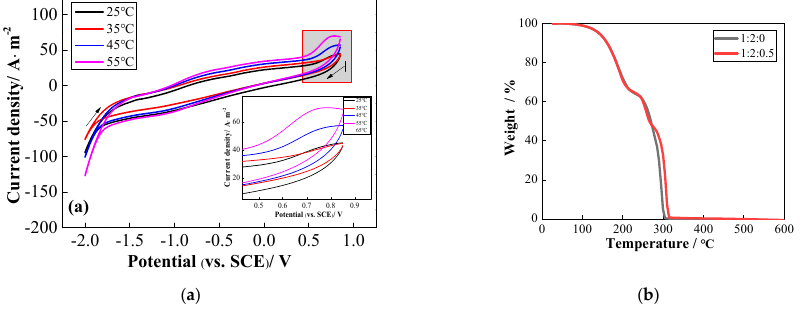
Figure 1. ( a ) Cyclic voltammograms of 1:2:0.5 TDES at different temperatures with a scan rate of 100 mV·s − 1 at room temperature (25 °C); ( b ) TG curves of BDES and 1:2:0.5 TDES. of BDES(TDES) show two mass drops, which means the decomposition of 2 organic com- ponents. The thermogravimetric curves of TDES show three mass drops, which means the decomposition of 3 organic components. The hydrogen bond network of the two solvents begins to break slightly at 4 °C and appears to obviously fracture above 10 °C. The decom- position rate of the hydrogen bond is accelerated above 150 °C. The components of the solvents began to decompose as the temperature continued to rise. Both solvents have better thermal stability. Viscosity has a great influence on the mass transfer in DESs, which is an important parameter that determines the efficiency of flow batteries. Viscosity is closely related to the intermolecular interaction of DES components. The stronger the hydrogen bonds be- tween molecules are, the bigger the viscosity of the prepared DES is [38]. The viscosity of DES is easily affected by the size of the cationic, anionic components, and the voids in the liquid [39]. Through the design of controlling the molar ratio of glycerin, the results sug- gest that the viscosity of the solvent in which the ratio of choline chloride to ethylene gly- col to glycerol of 1:2:0.5 decreases from 51.2 mPa·s for the binary eutectic solvent to 40.3 mPa·s after adding the redox pair (FeCl 3 ·6H 2 O) in Figure 2. The viscosity did not change much without the addition of the redox pair. The original hydrogen bond network struc- ture was appropriately destroyed by the introduction of glycerin and the low viscosity is obtained, which means that this design establishes a good balance and is beneficial to the flow battery. On the basis of controlling the viscosity of DES, the dynamics and efficiency are simultaneously improved. In the binary system, when the FeCl 3 ·6H 2 O redox pair is added, the hydrogen bonds of anions and cations in FeCl 3 ·6H 2 O can attract the -OH on the ethylene glycol to compete with choline chloride, forming a large number of relatively strong anion or neutral hydrogen bond, simultaneously supplying multiple sites of Cl. The coordination between CI and ethylene glycol occupies free sites, forming hydrogen bonds and van der Waals bonds of different strengths. The hexacoordinate FeCl 3 ·6H 2 O has an electron-withdrawing group, which can interact with ethylene glycol to form a single iron ligand. The ethylene glycol acts as a “bridge” to connect -OH, choline chloride with FeCl 3 ·6H 2 O to form a chloride ion–iron metal ion–ethylene glycol supramolecular complex [31]. When the battery is running, the large and complex molecular structure plays a great role in mass transfer resistance, and its viscosity is relatively large in Figure 2. After introducing the glycerol with different structures, the original hydrogen bond network structure is destroyed by microscopically adjusting the electronegativity differ- ence between the hydrogen bond donor, the hydrogen bond acceptor, and the length of